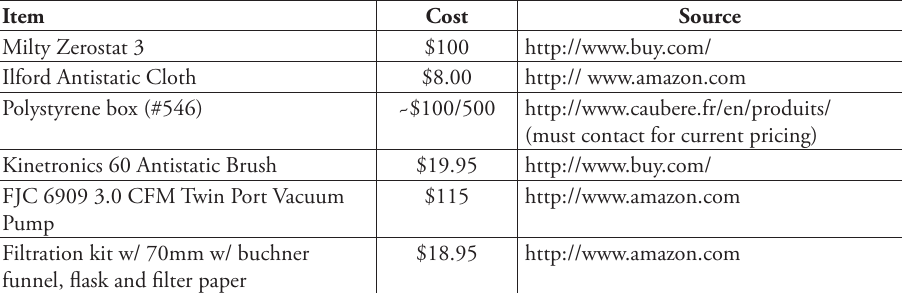
table 1. Cost of